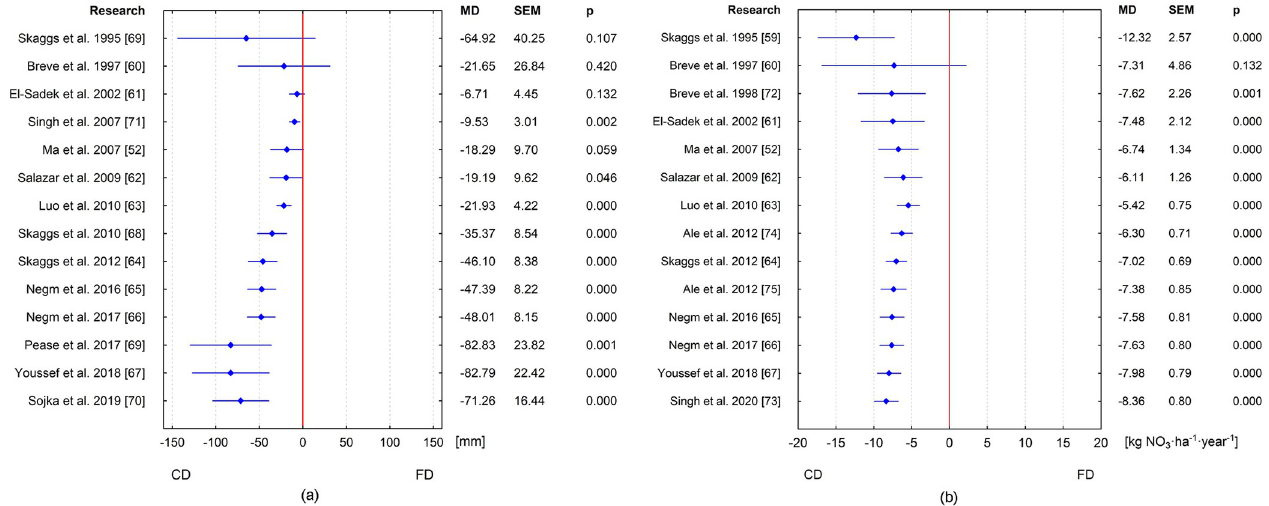
Fig 4. Cumulative meta-analysis: (a) subsurface drainage outflow reduction by CD versus FD; (b) reduction of nitrate load in drainage outflow by CD versus FD.